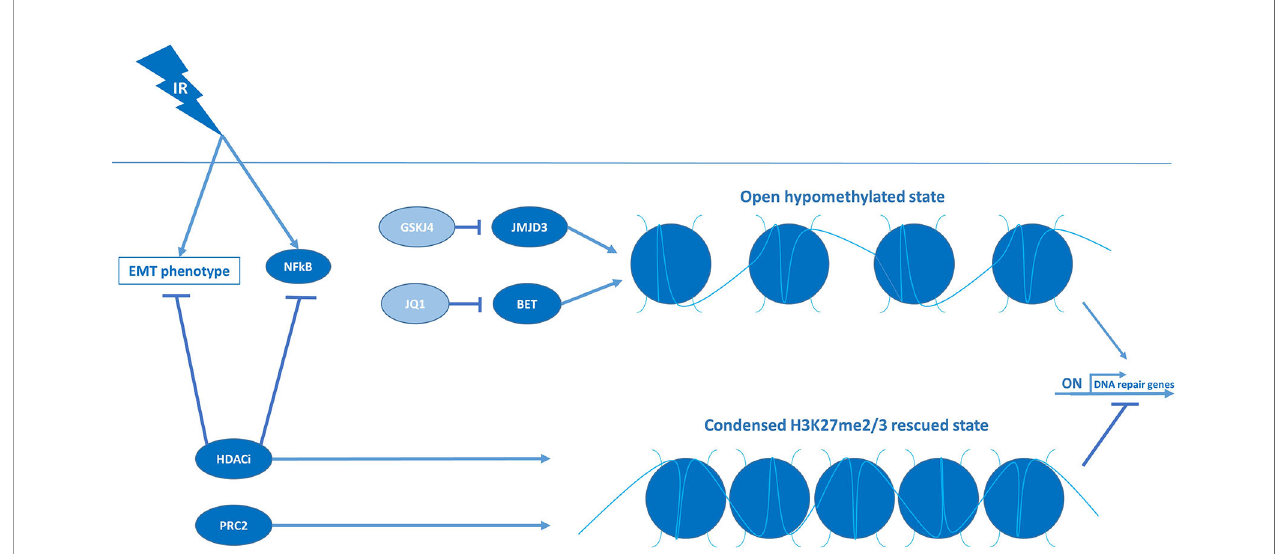
FIGURE 5 | Condensed chromatin structures suppress DNA-repair machineries and induce RT sensitivity in